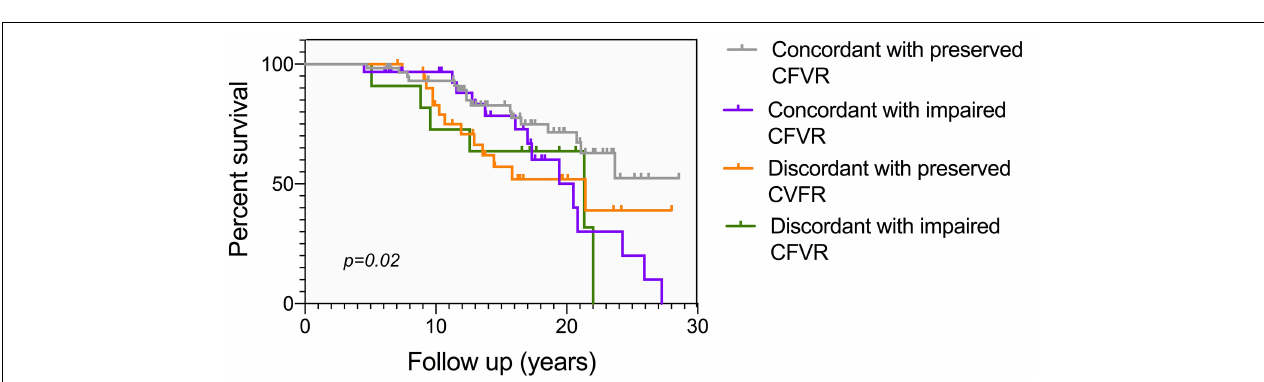
FIGURE 3 | Cardiovascular mortality in HT patients subdivided on the basis of CFVR and DPV h . Cardiovascular mortality observed in endotype and endotype 2 shows, as expected, the lowest level (27%). Endotype 1 and 3, even if with different CFVR patterns, have comparable mortality rates (41 and 45%, respectively), while endotype 4 has the overall highest mortality (55%).